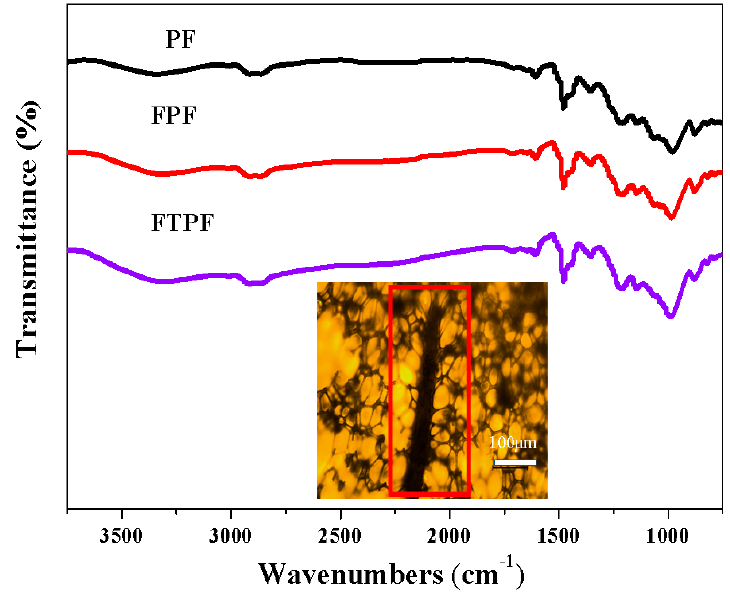
Figure 2. FTIR spectra of phenolic foam (PF), FPF, and wood fiber-reinforced FPF (FTPF).